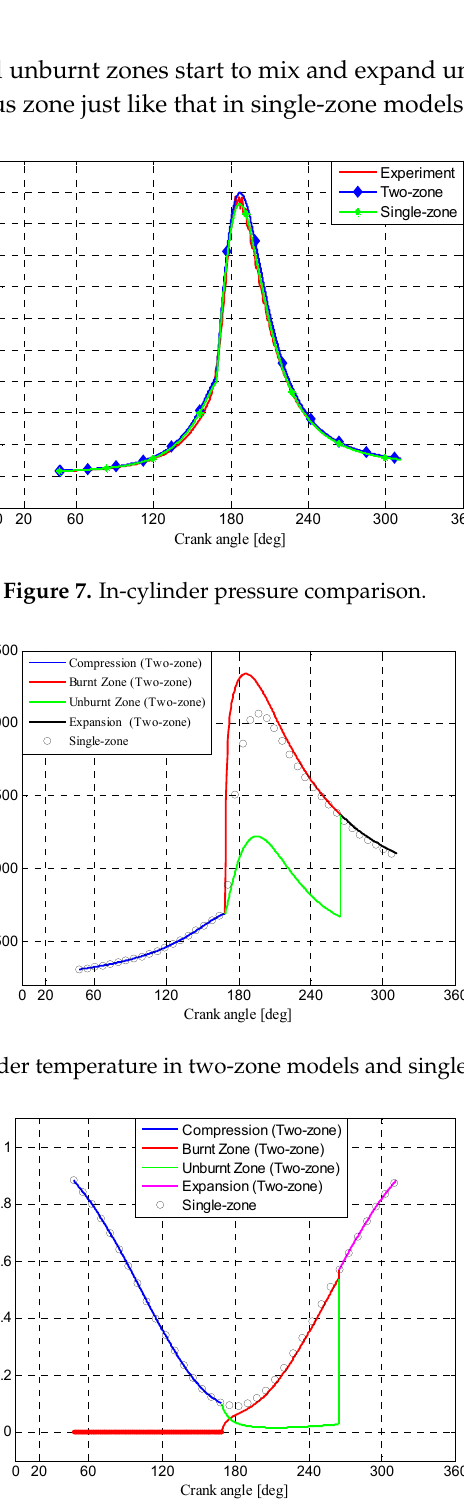
Figure 9. Volume ratio in two-zone models and single-zone models.